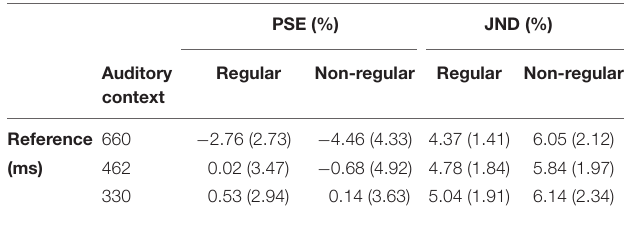
percentages of the reference interval allowed us to compare the influence of the auditory context across reference